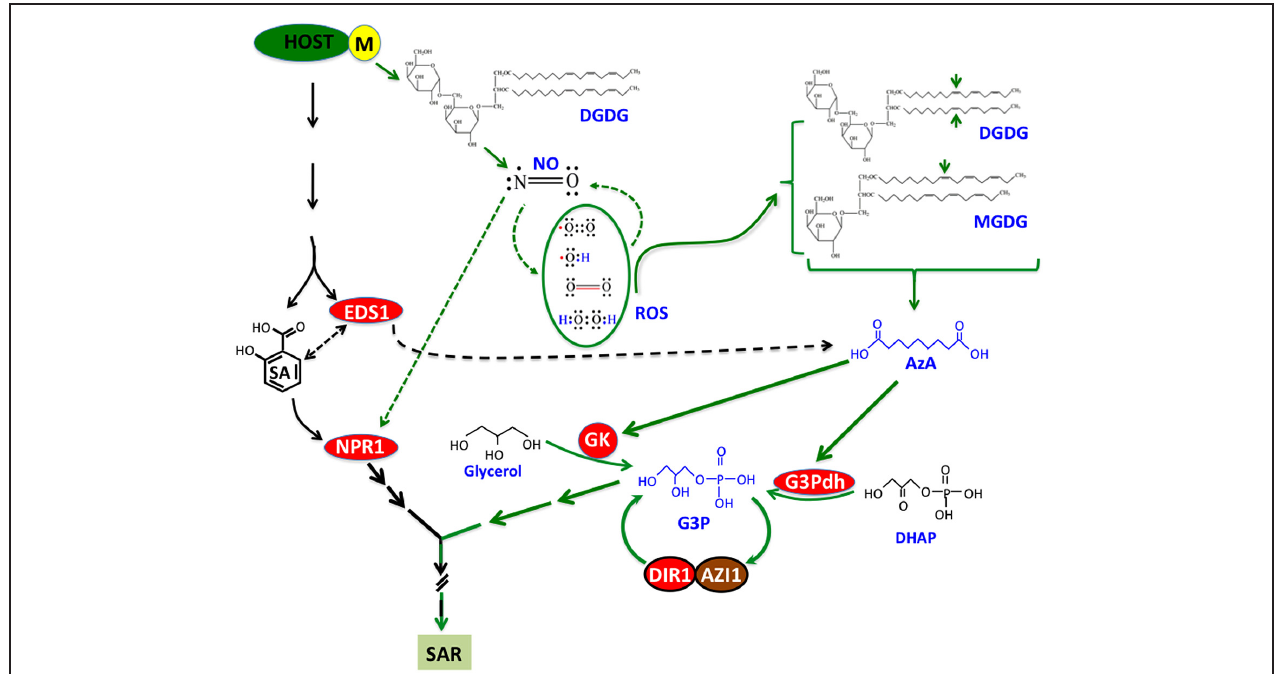
FIGURE 2 | A simplified model showing pathways, chemicals, and proteins involved in SAR. Infection with avirulent (avr) pathogen induces accumulation of SA and nitric oxide (NO) in a digalactosyldiacylglycerol (DGDG)-dependent manner. NO operates in a feedback loop with reactive oxygen species (ROS), which catalyze oxidation of C18 unsaturated fatty acids (FA) present on monogalactosyldiacylglycerol (MGDG) and DGDG lipids. Oxidation of C18 FAs at C9 carbon (indicated by the arrows) generates azelaic acid (AzA), which triggers biosynthesis of glycerol-3-phosphate (G3P)